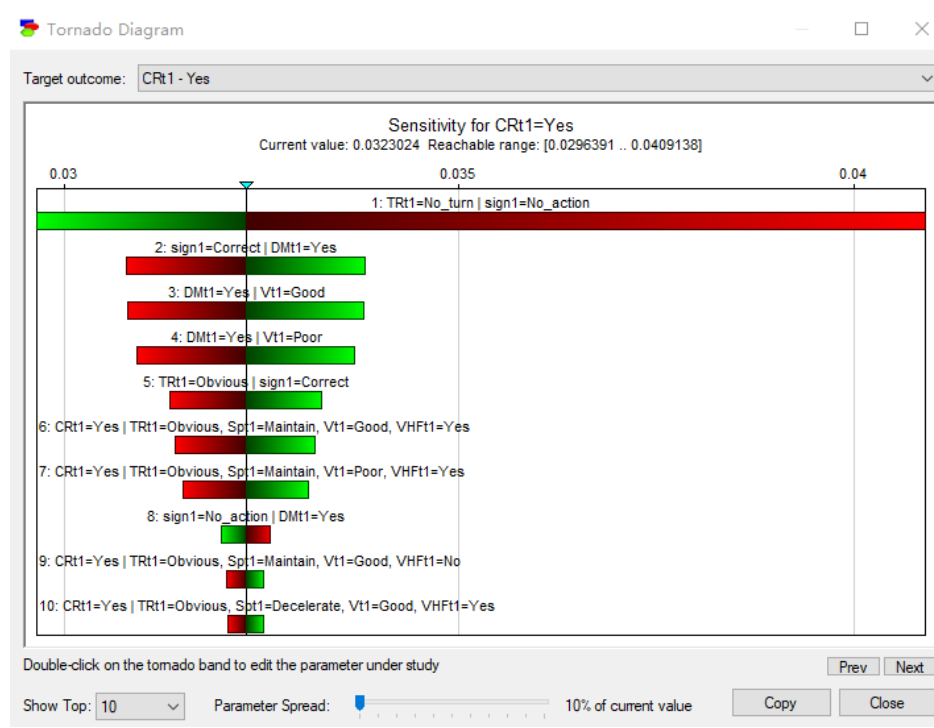
Figure 9. Tornado diagram with “CRt 1 ” as the target variable for sensitivity analysis.